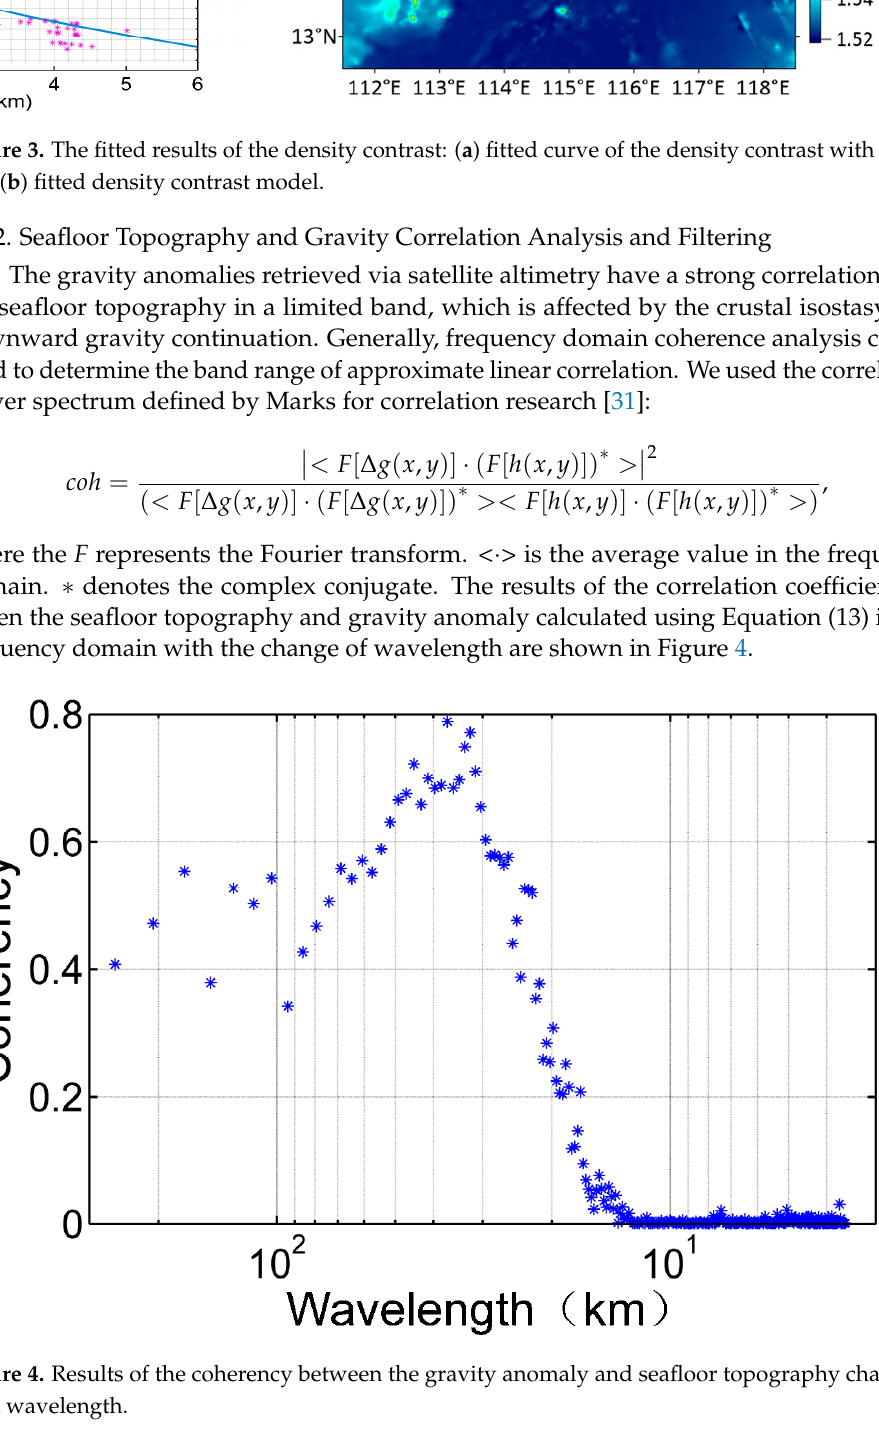
Figure 4. Results of the coherency between the gravity anomaly and seafloor topography changing with wavelength.